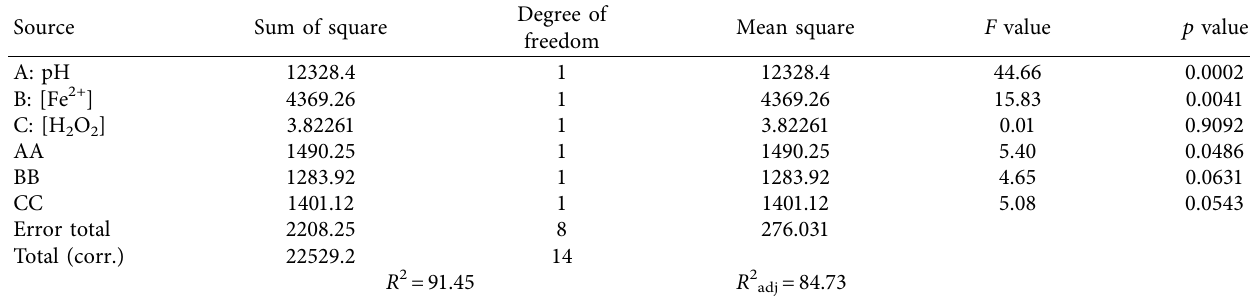
CN polynomial model (%).